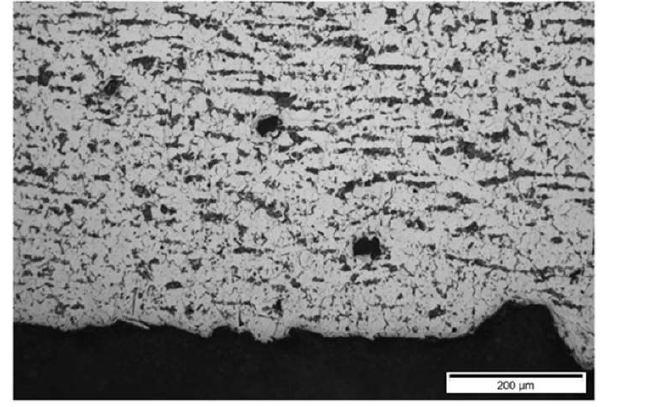
Figure 20. Examined section’s general view.